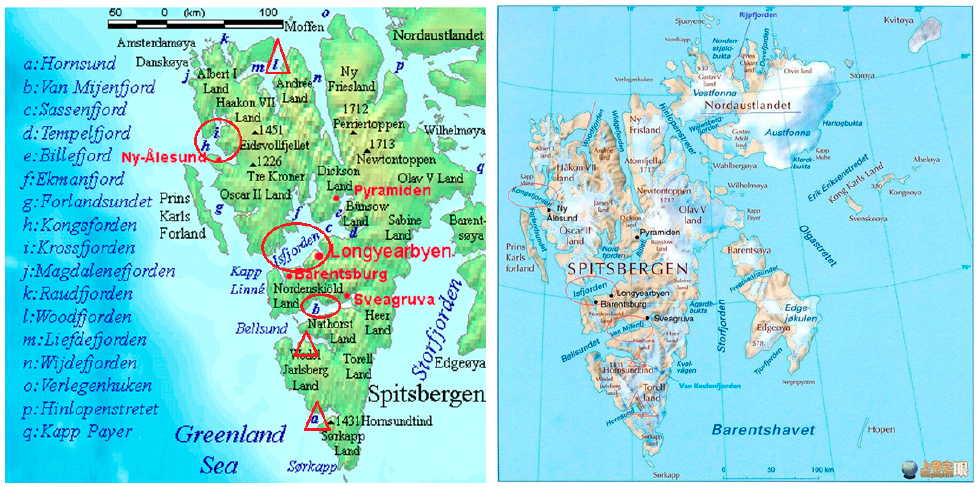
Figure 4. Distribution of various fjords on Svalbard.